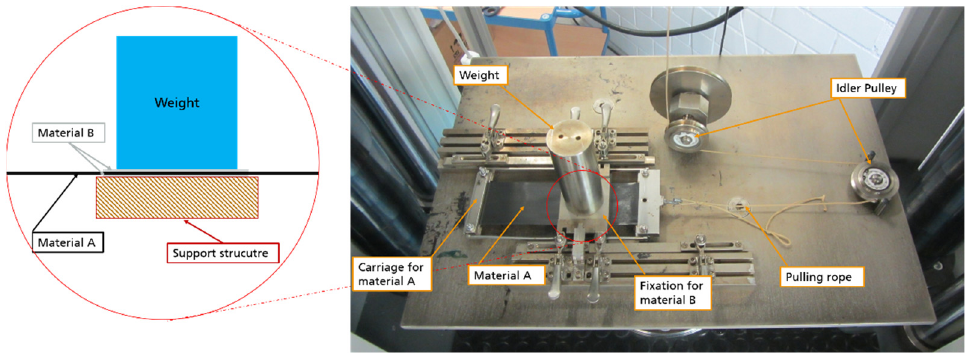
Figure 17. Test rig for measurement of frictional forces between FRP sheet and clamp materials.